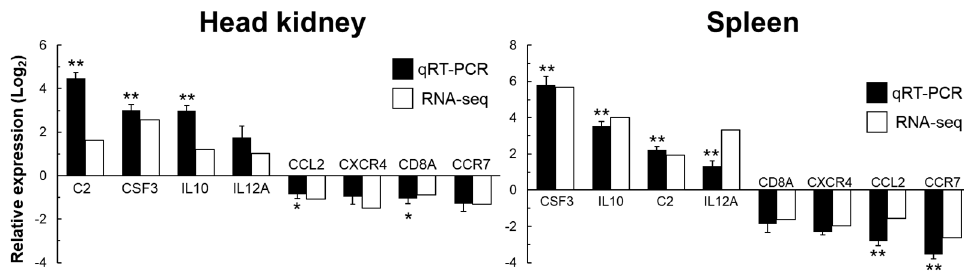
Figure 2. Validation of RNA-seq data by RT-qPCR. A gene expression level analysis in the head kidney and spleen from RNA sequencing (RNA-Seq) and reverse transcription quantitative real-time PCR (RT-qPCR) assays of fish infected with Streptococcus iniae . Total RNA samples from the head kidney and spleen were extracted, and the expression levels of each gene were determined using RT-qPCR assays. Expression levels of each target gene were normalized using HMBS as a control gene. The graph shows the relative gene expression levels of the S. iniae -infected and phosphate-buffered saline (PBS)-treated groups ( n = 6, * p < 0.05, ** p < 0.01 compared to the PBS group). Table 1. Functional enrichment analysis results of KEGG pathways for specific and common differen- tially expressed genes (DEGs) in the head kidney and